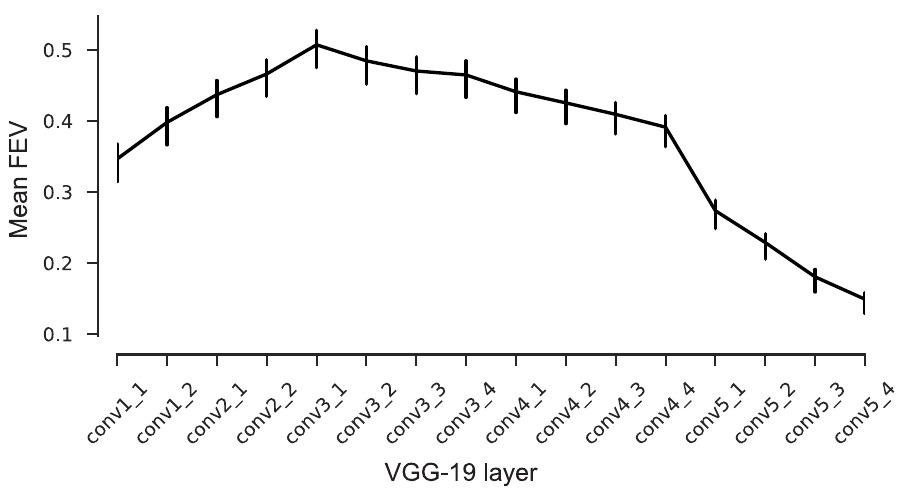
Fig 4. Model performance on test set. Average fraction of explainable variance explained ( FEV ) for models using different VGG layers as nonlinear feature spaces for a GLM. Error bars show 95% confidence intervals of the population means. The model based on layer conv3_1 shows on average the highest predictive